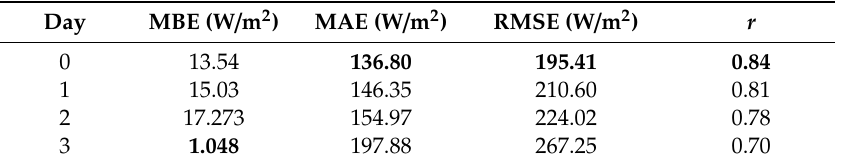
Table 1. Statistical indicators of comparison between observed and predicted hourly mean Direct Normal Irradiance (DNI) for the entire period (1 August 2018–31 July 2019). Bold values mean the best score. Day MBE (W / m 2 ) MAE (W / m 2 ) RMSE (W / m 2 ) r